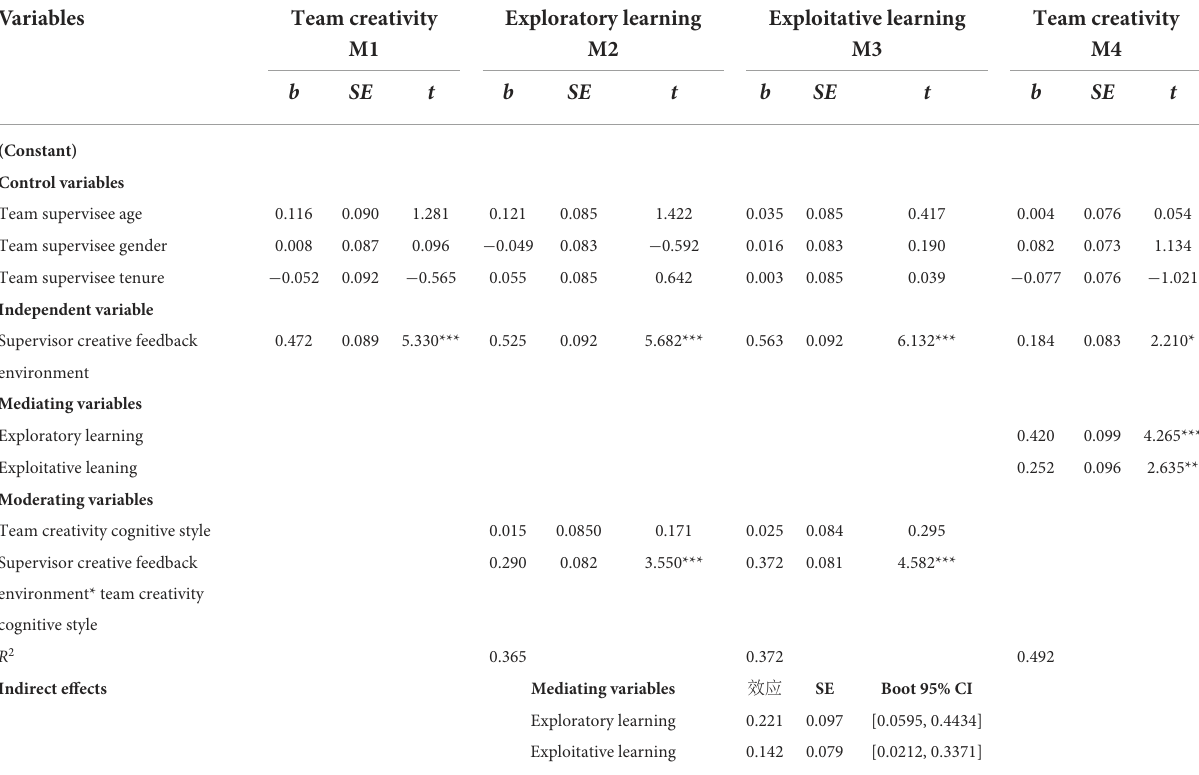
TABLE 3 Summary regression table of moderating mediation